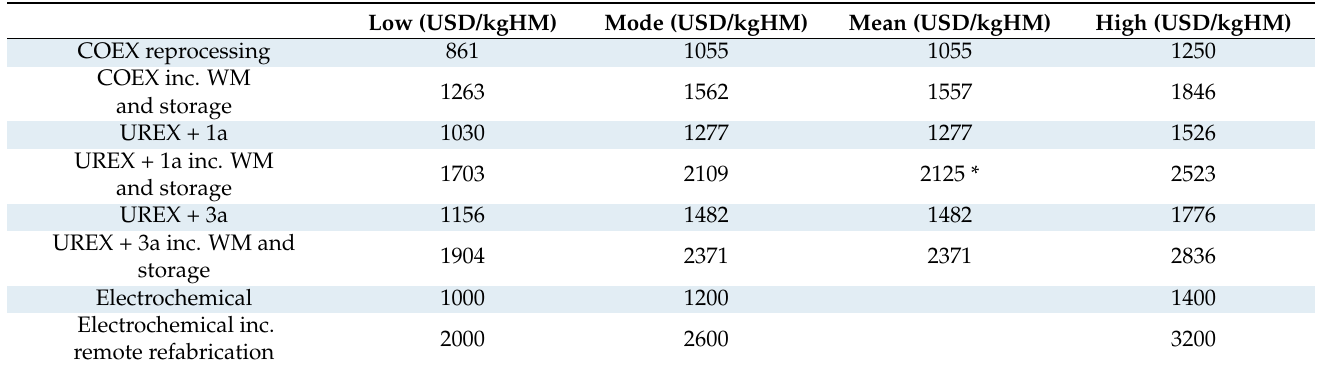
Table 6. AFC cost data for three aqueous reprocessing options (with and without waste conditioning and storage costs included), and electrochemical (pyro-) processing (with and without remote fuel fabrication costs) of spent fuel in 2017 USD [49]. Low (USD/kgHM) Mode (USD/kgHM) Mean